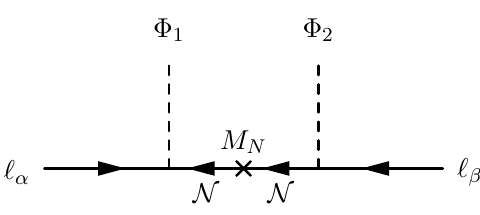
Figure 1 . Light neutrino mass generated by the type Ib seesaw